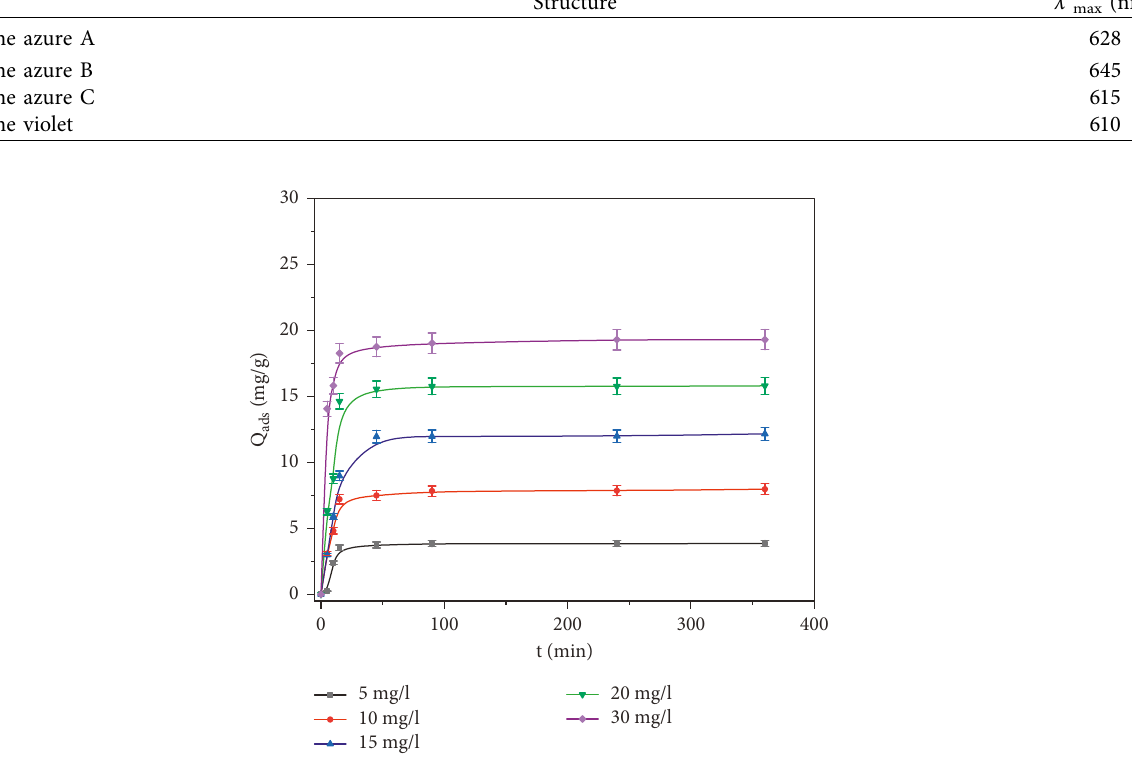
Figure 10: Effect of initial concentration and contact time on MB removal and adsorption capacity of PANI-EB at 30 ° C and pH 8. Table 4: Kinetic parameters for the MB adsorption on PANI-EB at pH 8 and 30 ° C.